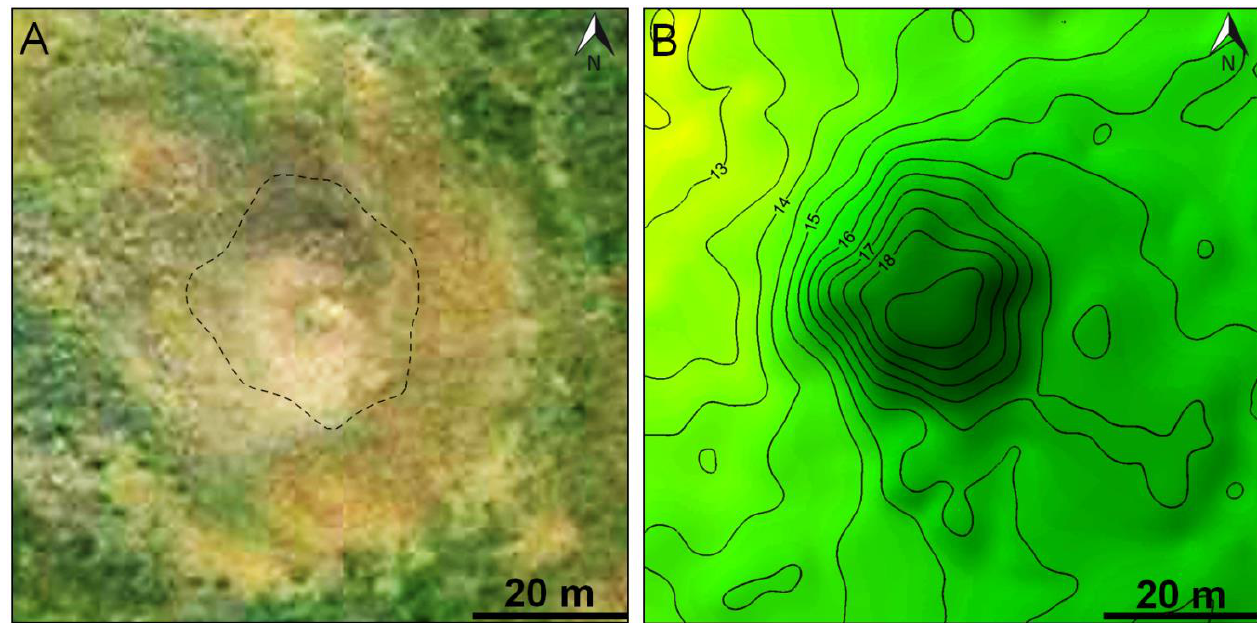
Figure 7. WorldView-2 satellite image of the perennial heaving mound on the site of the C17 object (ESRI) ( A ) and ArcticDEM on 21 of July, 2013 ( B ).